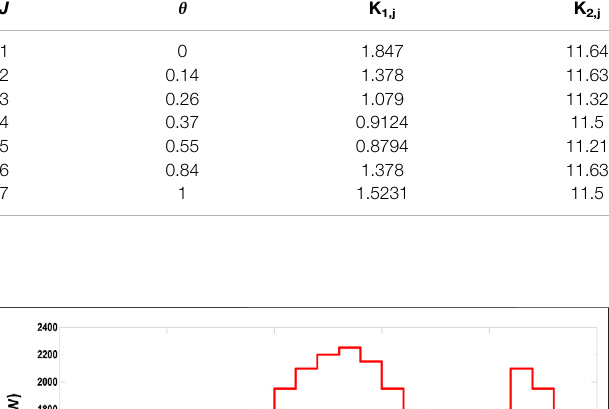
TABLE 5 | Forecasted power from solar PV and wind generators (Scenario-1, case study 2). Time (h) Solar (MW)